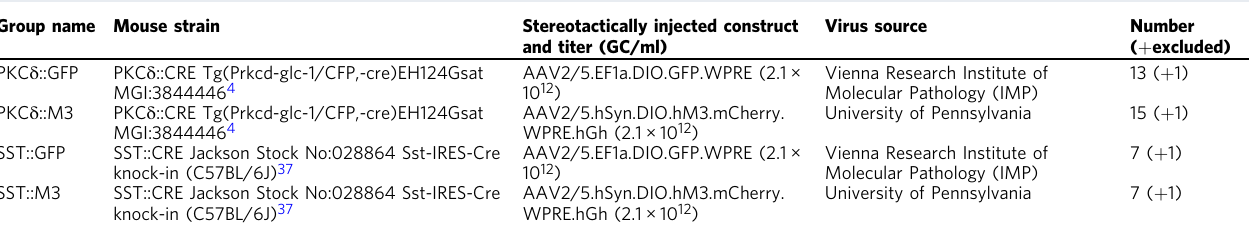
Table 1 Group assignments and sample sizes for behavior combined with DREADD chemogenetic activation.